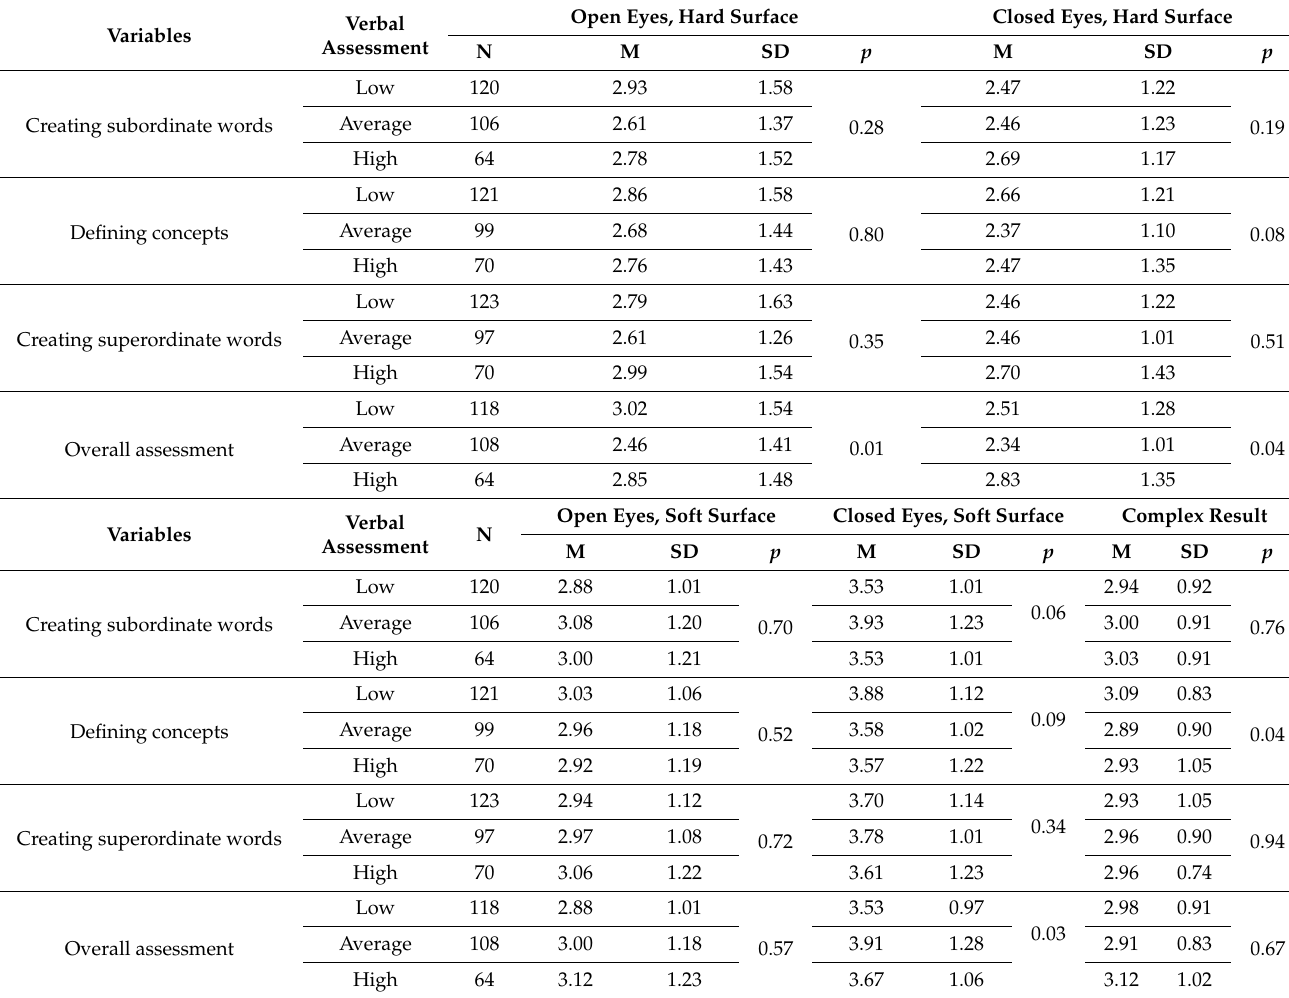
Table 3. Clinical Test of Sensory Integration and Balance in children with varied vocabulary development.